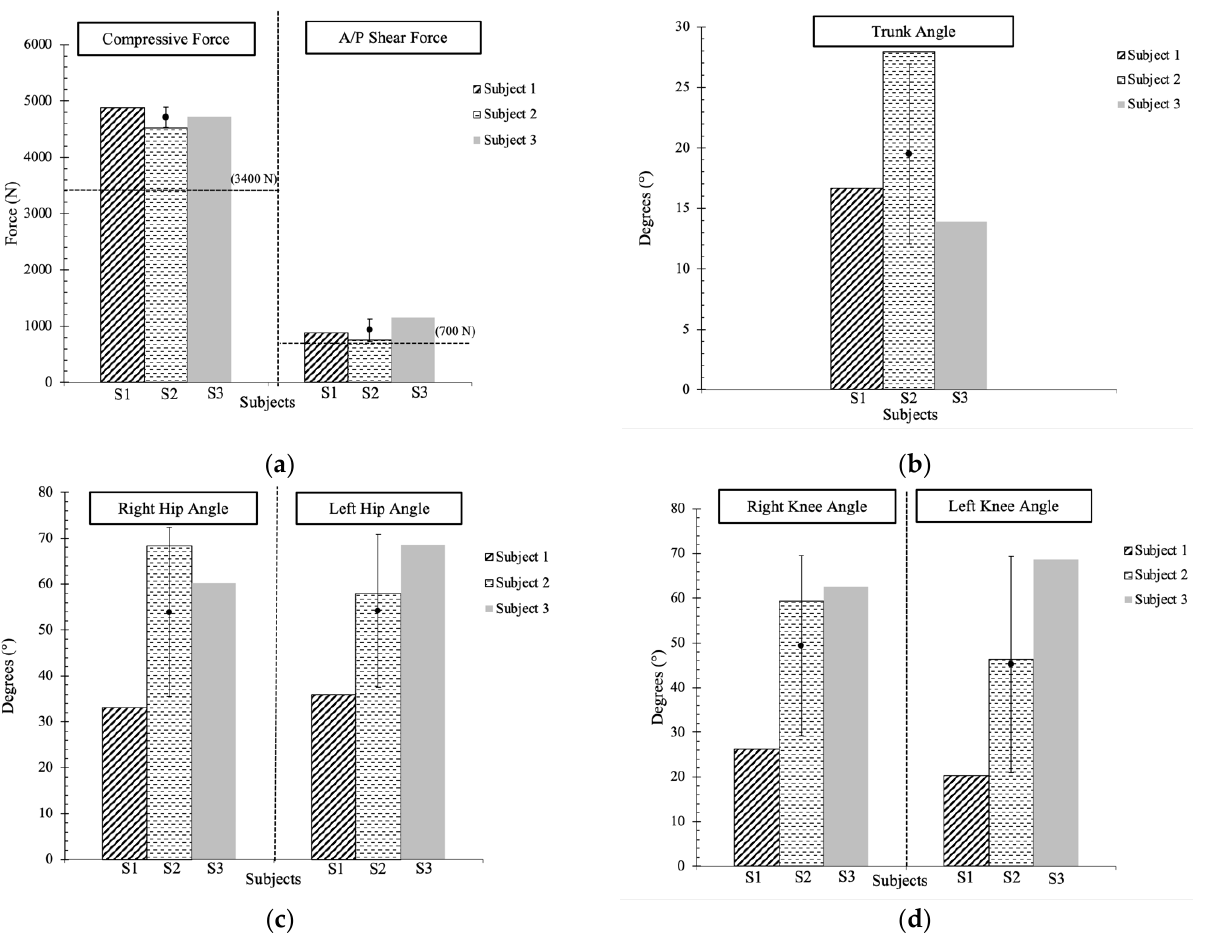
Figure 7. The analyzed results at Pose#1 in Task#2: ( a ) the exposed spinal forces with the recom- mended safety threshold values; ( b ) the trunk angles; ( c ) the hip angles; ( d ) the knee angles.